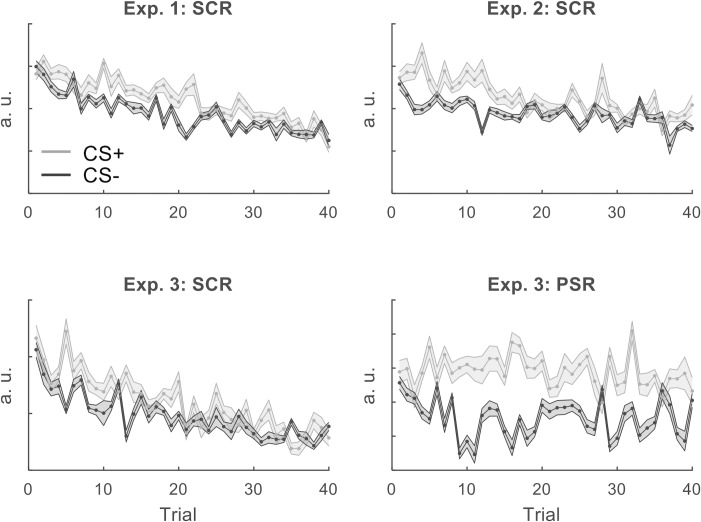
Single trial estimates for SCR and PSR for three experiments, for CS+ / CS- trials.The estimates are derived from psychophysiological models (PsPMs) for anticipatory SCR and PSR. As in our analyses, only US- trials are shown. Because there are twice as many CS- (dark gray) than CS+US- (light gray) trials, we only display CS- responses for every second CS- trial to simplify presentation, but include all CS- responses in our analyses. Shaded bars reflect the standard error across participants.